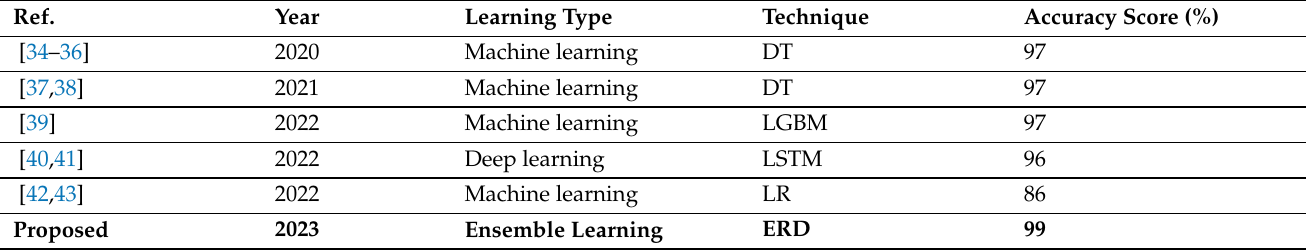
Table 9. Comparative analysis of the proposed ERD approach with the other state-of-art studies.